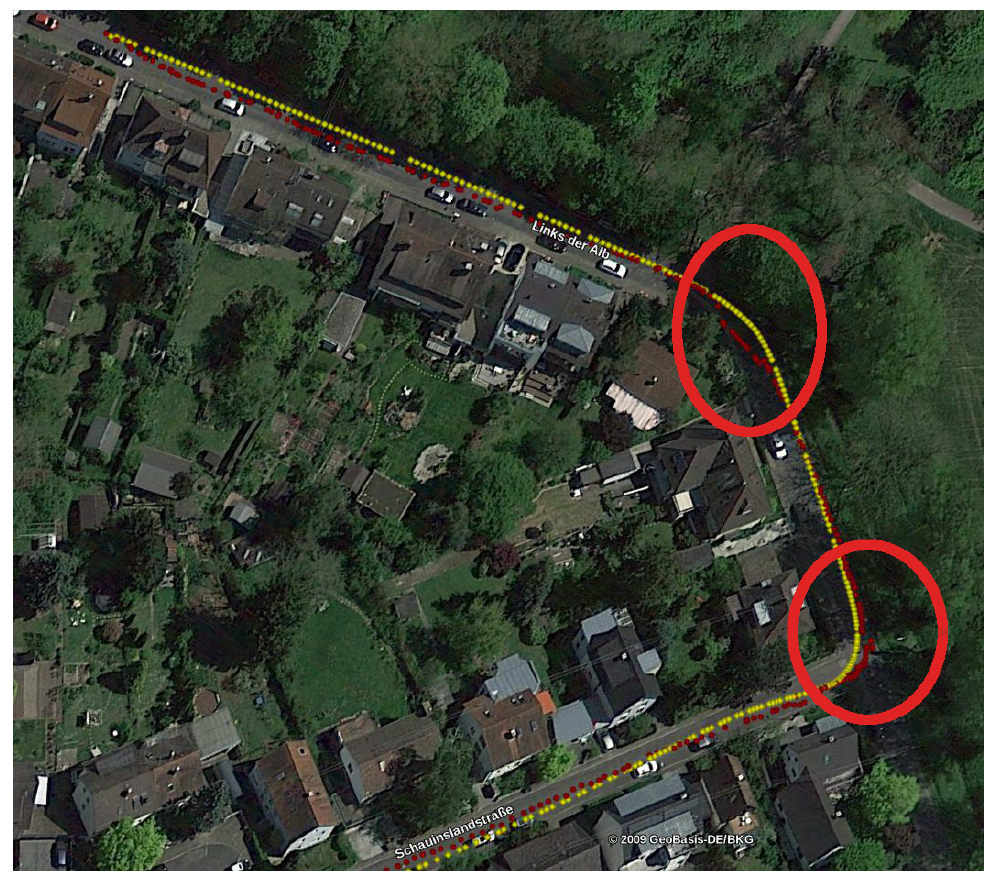
Figure 8. The trajectory for the 2011_09_30_drive_0028 sequence. Yellow points are the positions as measured by the GPS, red points are the position estimates of our proposal. Critical sections where surrounding buildings are not visible are circled in red.